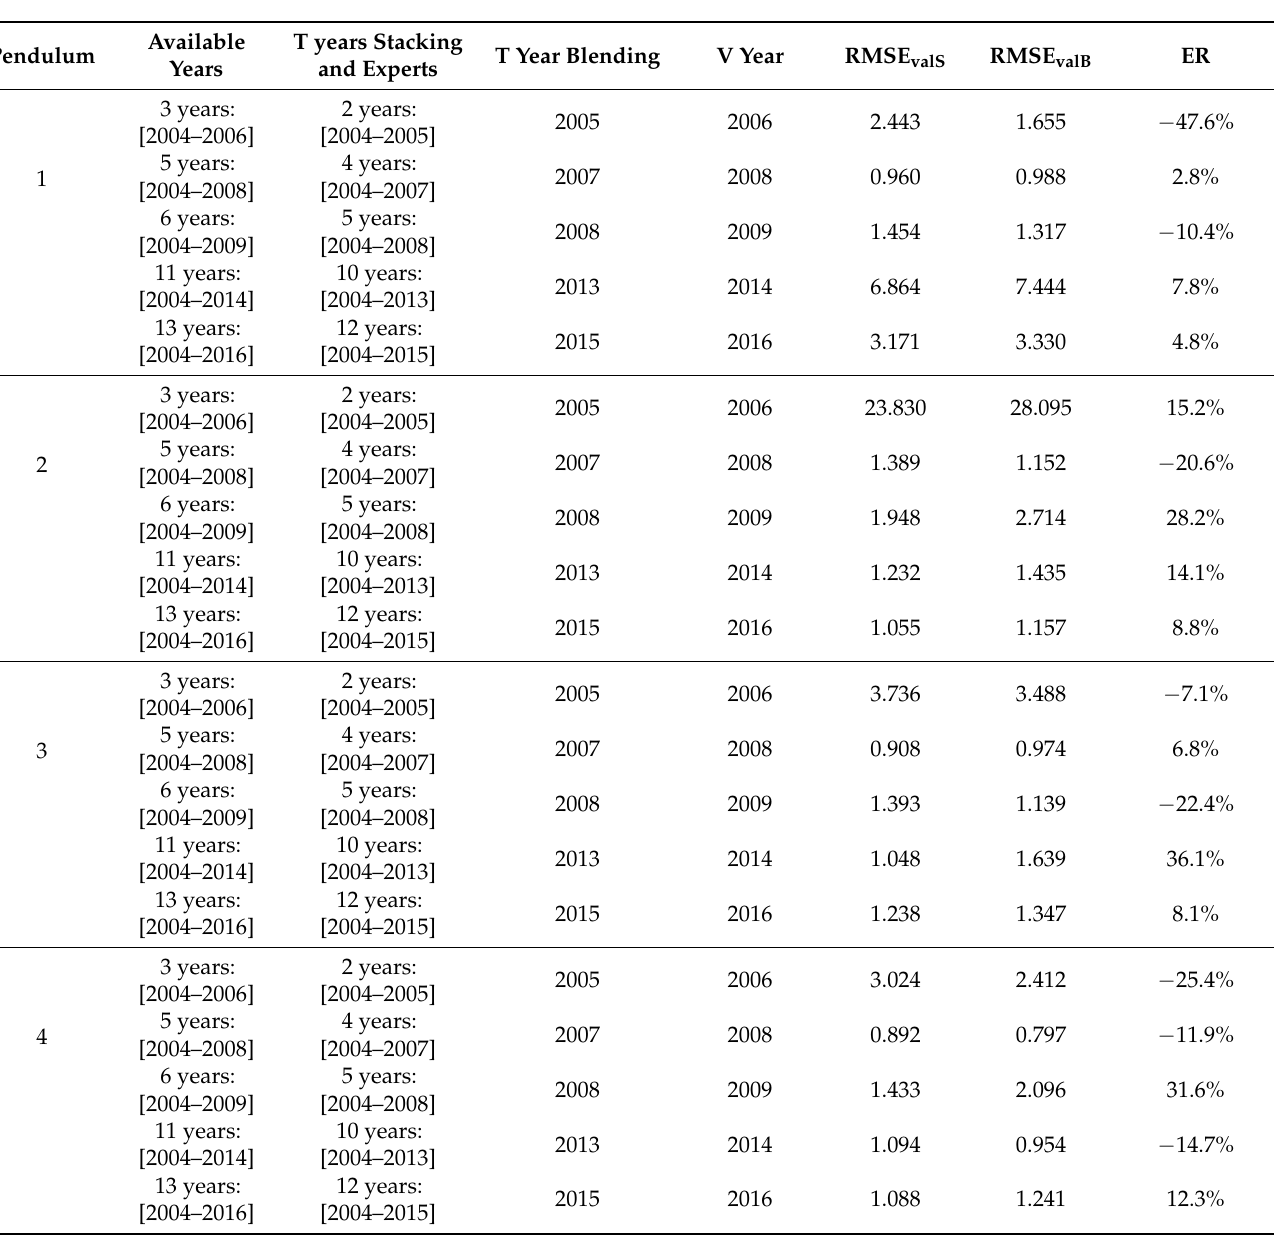
Table 5. Results of Test II, which consists of training the experts, Stacking and Blending meta-learners, with different training sets. Positive values of ER imply a lower error on the Stacking meta-learner than Blending.